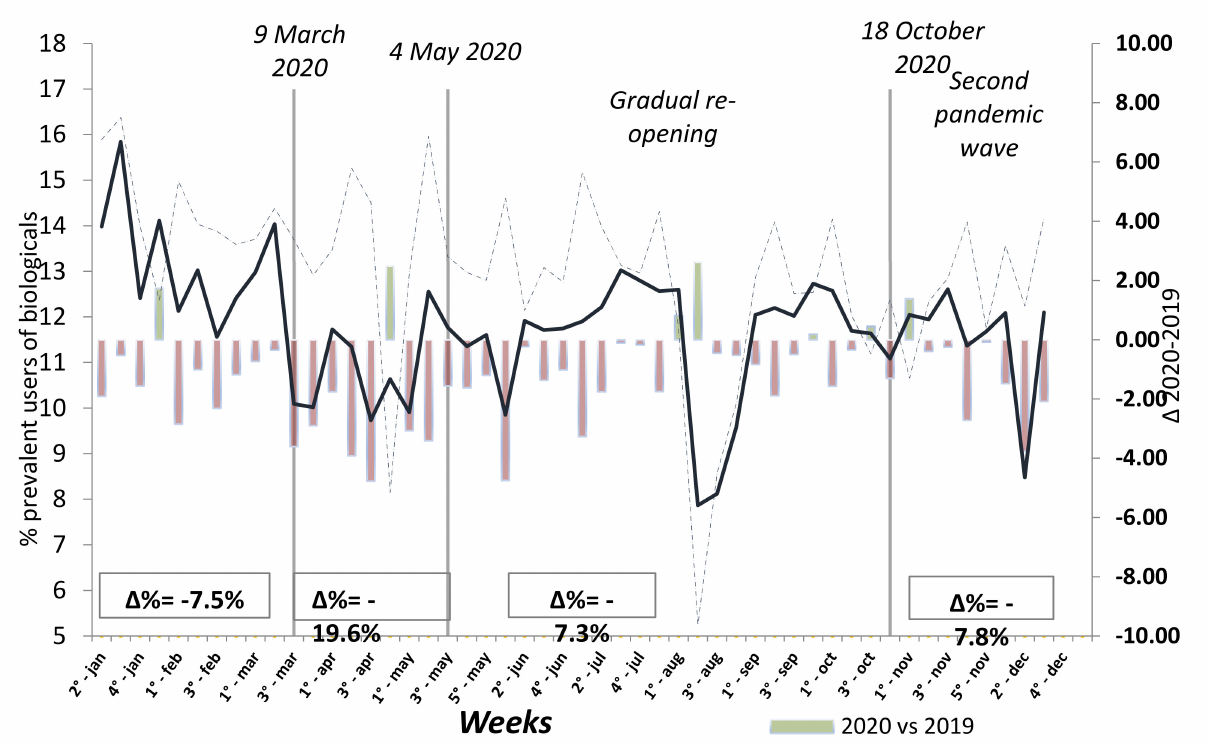
Figure 2. Prevalence of weekly use of biologic drug treatments in patients affected by IMDs previously treated with biologic